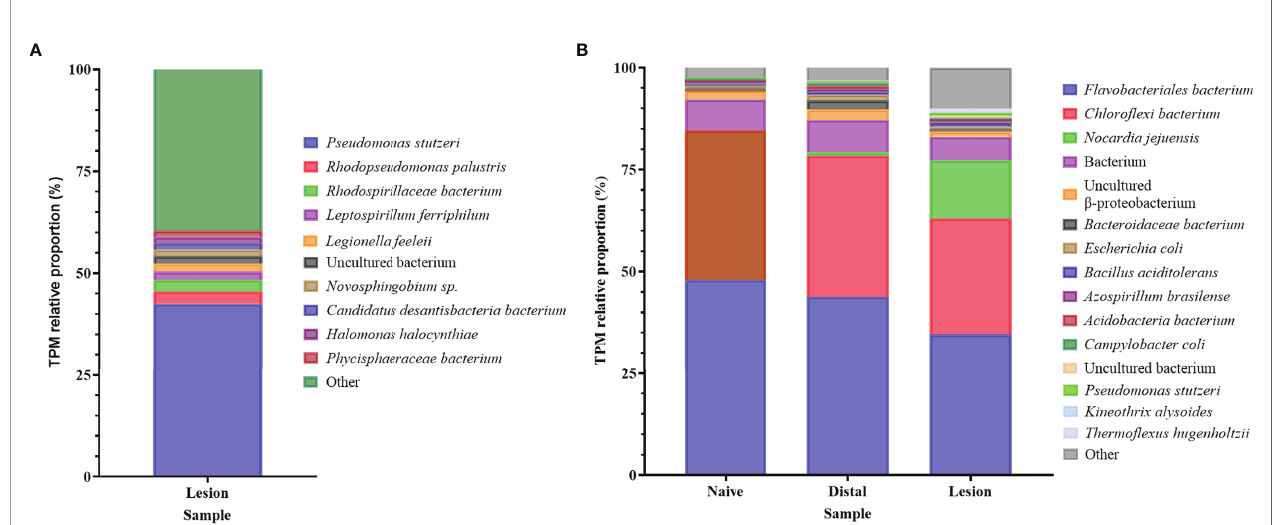
FIGURE 4 | Bar plot of the bacterial taxa identi fi ed from sequence reads. (A) Bacterial taxa identi fi ed in the unmapped Neoparamoeba perurans transcriptome. While the community diversity of 142 species was plotted to show visual diversity, only the top 12 candidates based on proportional reads (>1% TPM) are denoted in the legend. (B) Bacterial taxa identi fi ed in the unmapped Atlantic salmon gill transcriptome from naïve fi sh, biopsies distal to AGD lesions, and the AGD lesion data. The top 15 candidates based on proportional reads (>1% TPM) are denoted in the